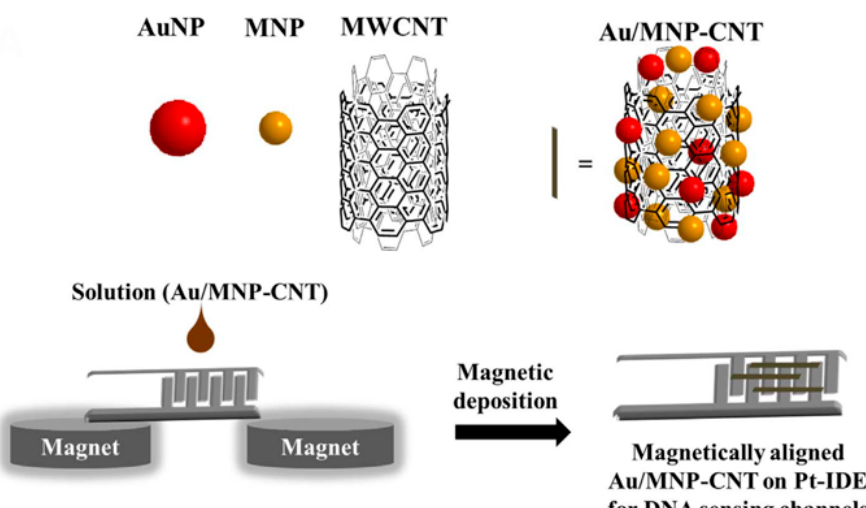
Figure 13. Schematic illustration of fabrication of magnetically aligned gold/magnetic nanoparticles decorated CNT on Pt-IDE for virus DNA-sensing platform. Image reproduced with permission from [219]. Copyright 2018 Elsevier.